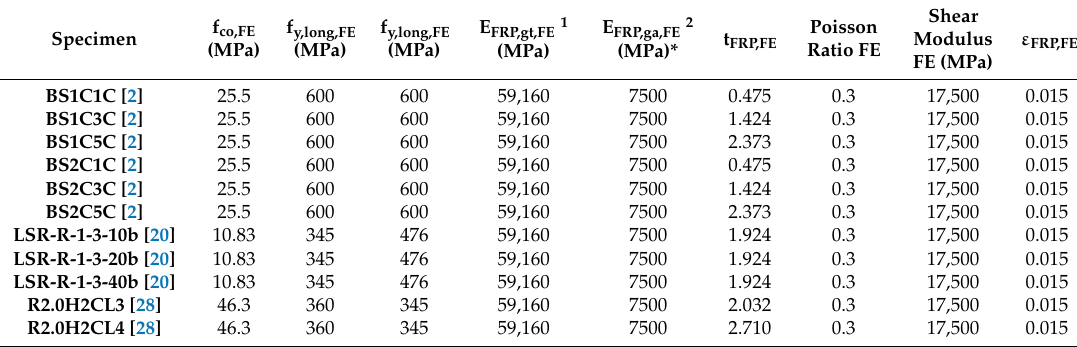
Table 2. Mechanical data used in the 3-dimensional finite element (FE)